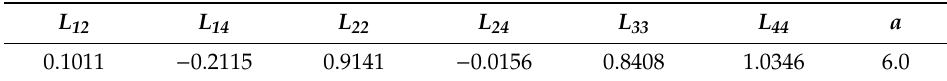
Table 3. CPB-06 fitted coefficients.